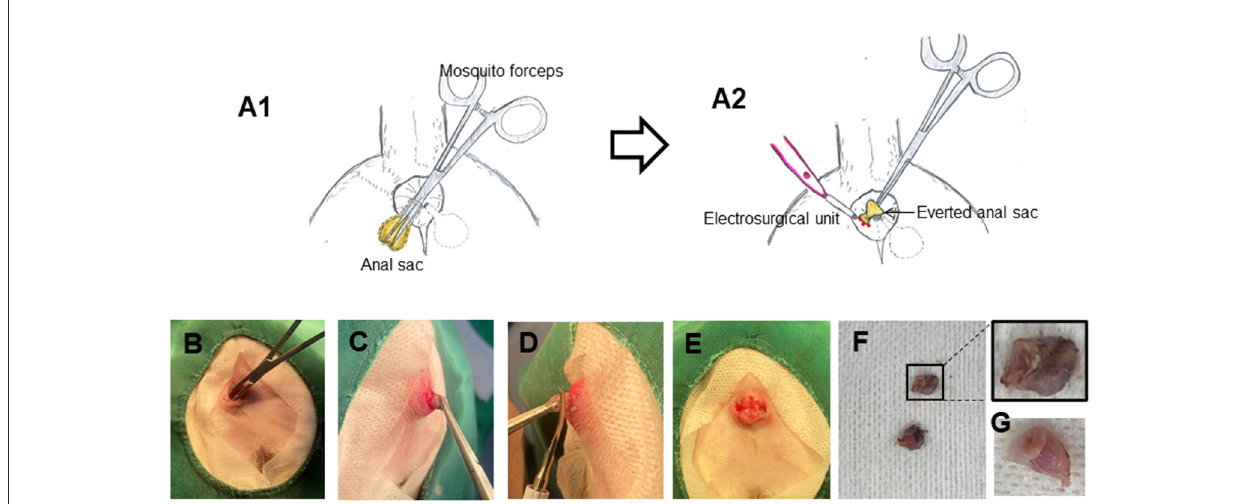
FIGURE1 Inside-Out anal sacculectomy. (A) Schematic diagrams of Inside-Out anal sacculectomy. (B–G) Photographs showing Inside-Out anal sacculectomy in a dog. A mosquito hemostatic forceps was inserted into the anal sac (B) , and the anal sac was everted (C) . The anal sac was then excised by a monopolar electrocautery surgical unit (D, E) . The completely incised anal sacs (F, G) .